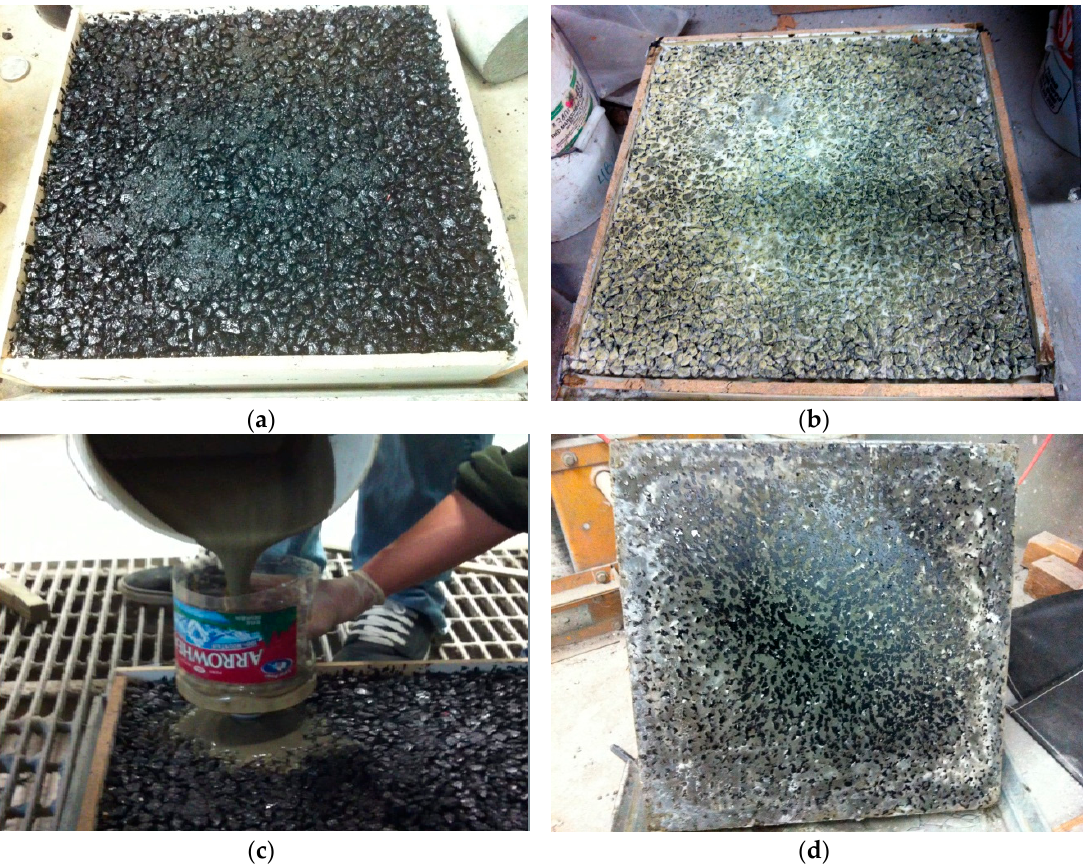
Figure 2. Sample preparation before and after cement mortar pouring. ( a ) Sample before filling cement mortar, ( b ) sample after filling cement mortar, ( c ) cement mortar pouring, ( d ) sample bottom.